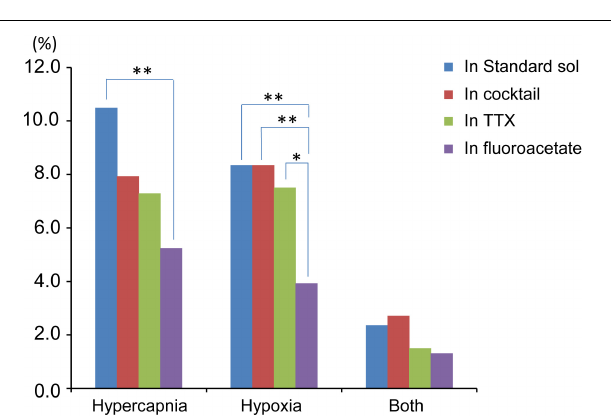
FIGURE 6 | Summary of percentage of responding cells to total cell number based on Table 1 . Hypercapnia, cells that responded to hypercapnic stimulation (2% CO 2 → 8% CO 2 ). Hypoxia, cells that responded to hypoxic stimulation (95% O 2 → 0% O 2 ). Both, cells that responded to both hypercapnic and hypoxic stimulations. Each bar indicates different extracellular conditions: standard solution (sol), cocktail blockers solution, 0.5